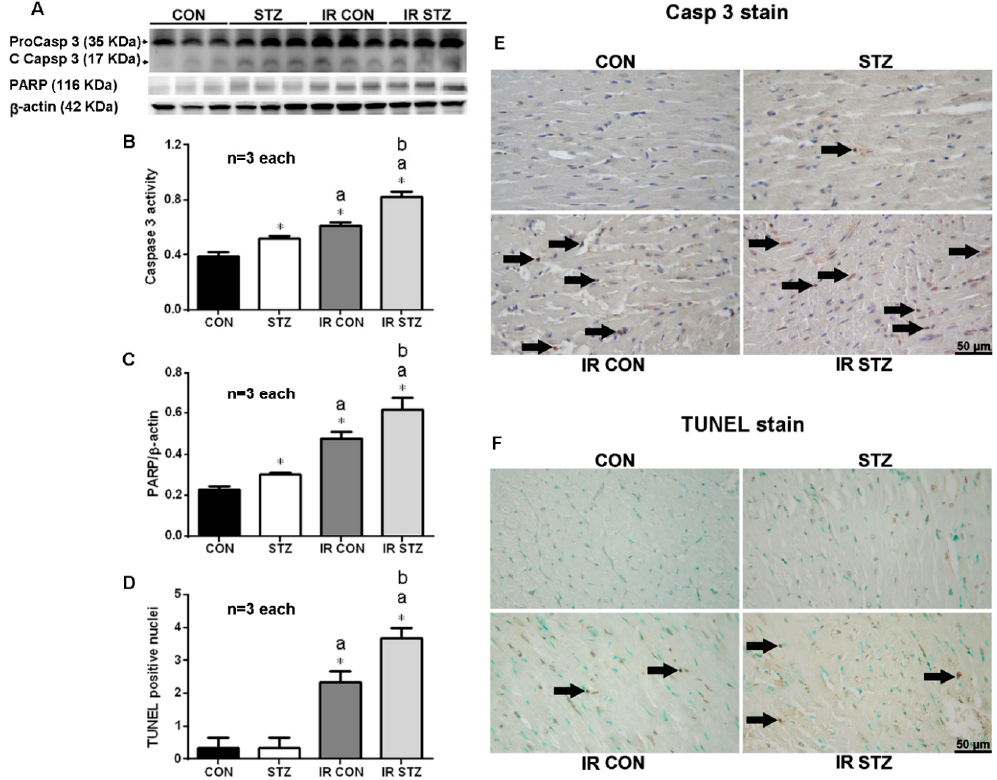
Figure 7. Western plot ( A ) and immunohistochemistry ( E–F ) of myocardial caspase 3, and PARP and apoptosis TUNEL stain in IR myocardium. The statistic data in Caspase 3 ( B ), PARP ( C ) and TUNEL positive nuclei ( D ) are indicated. Data are expressed as mean ± SEM ( n = 3) using the single values. * p < 0.05 vs. CON. a p < 0.05 vs. STZ. b p < 0.05 vs. IR CON.